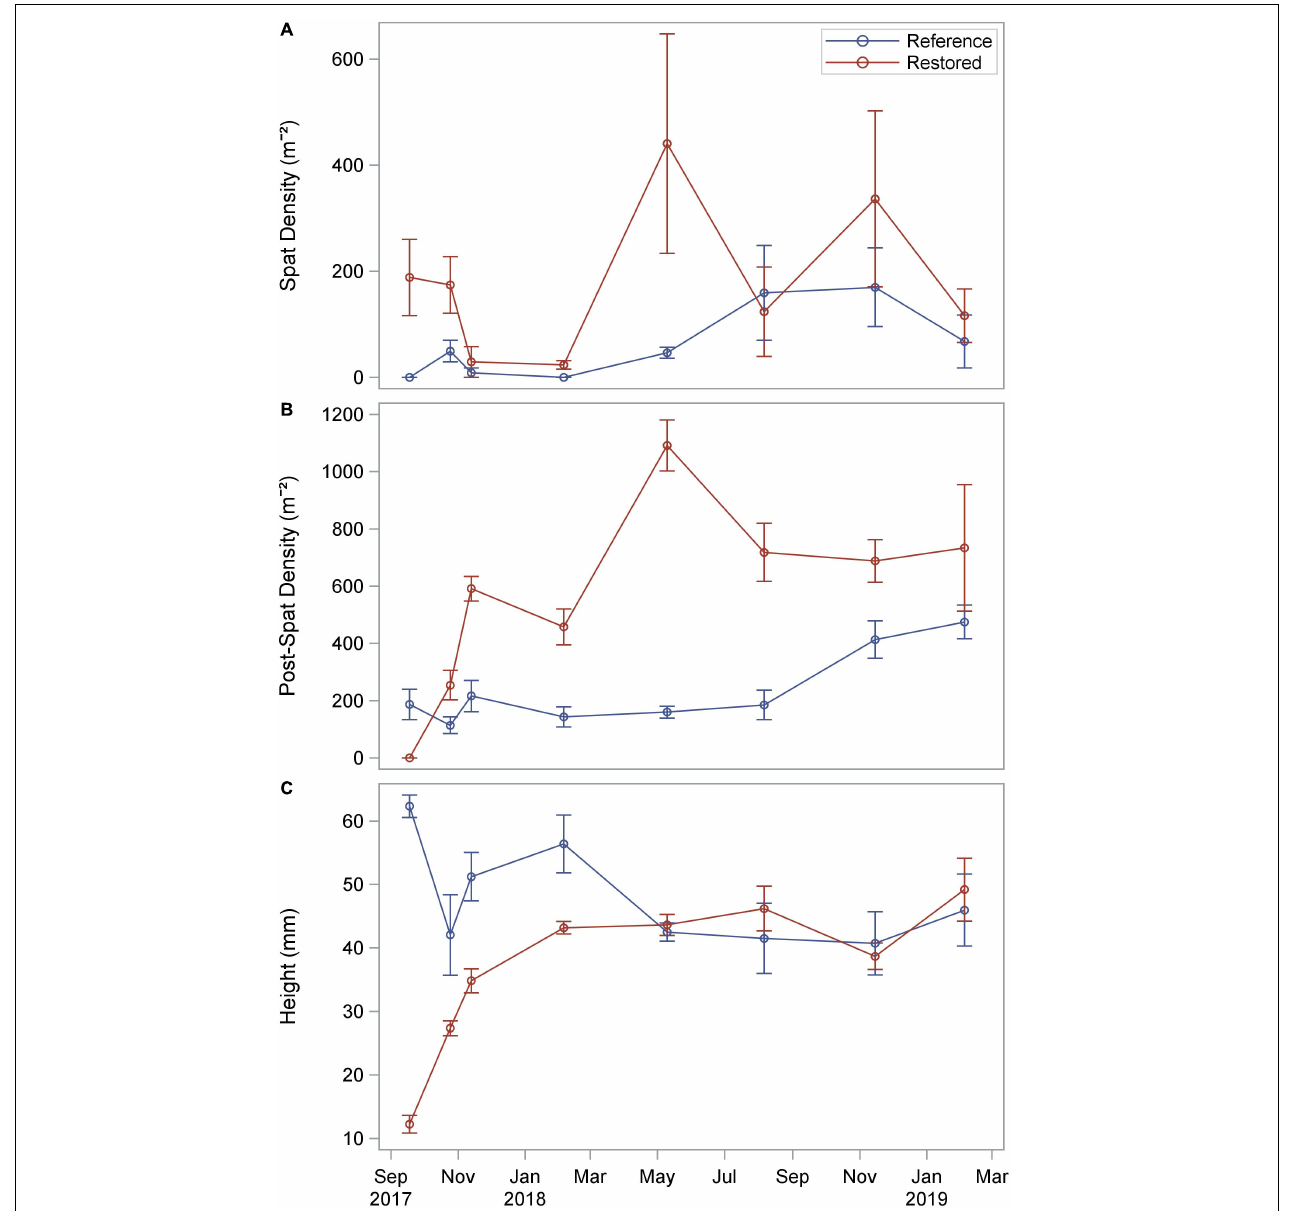
FIGURE 3 | Mean density of oyster spat ( ≤ 25 mm; A ) and larger size classes ( ≥ 26 mm; B ), and oyster size (shell height; C ) on the restored and reference reefs from September 2017-February